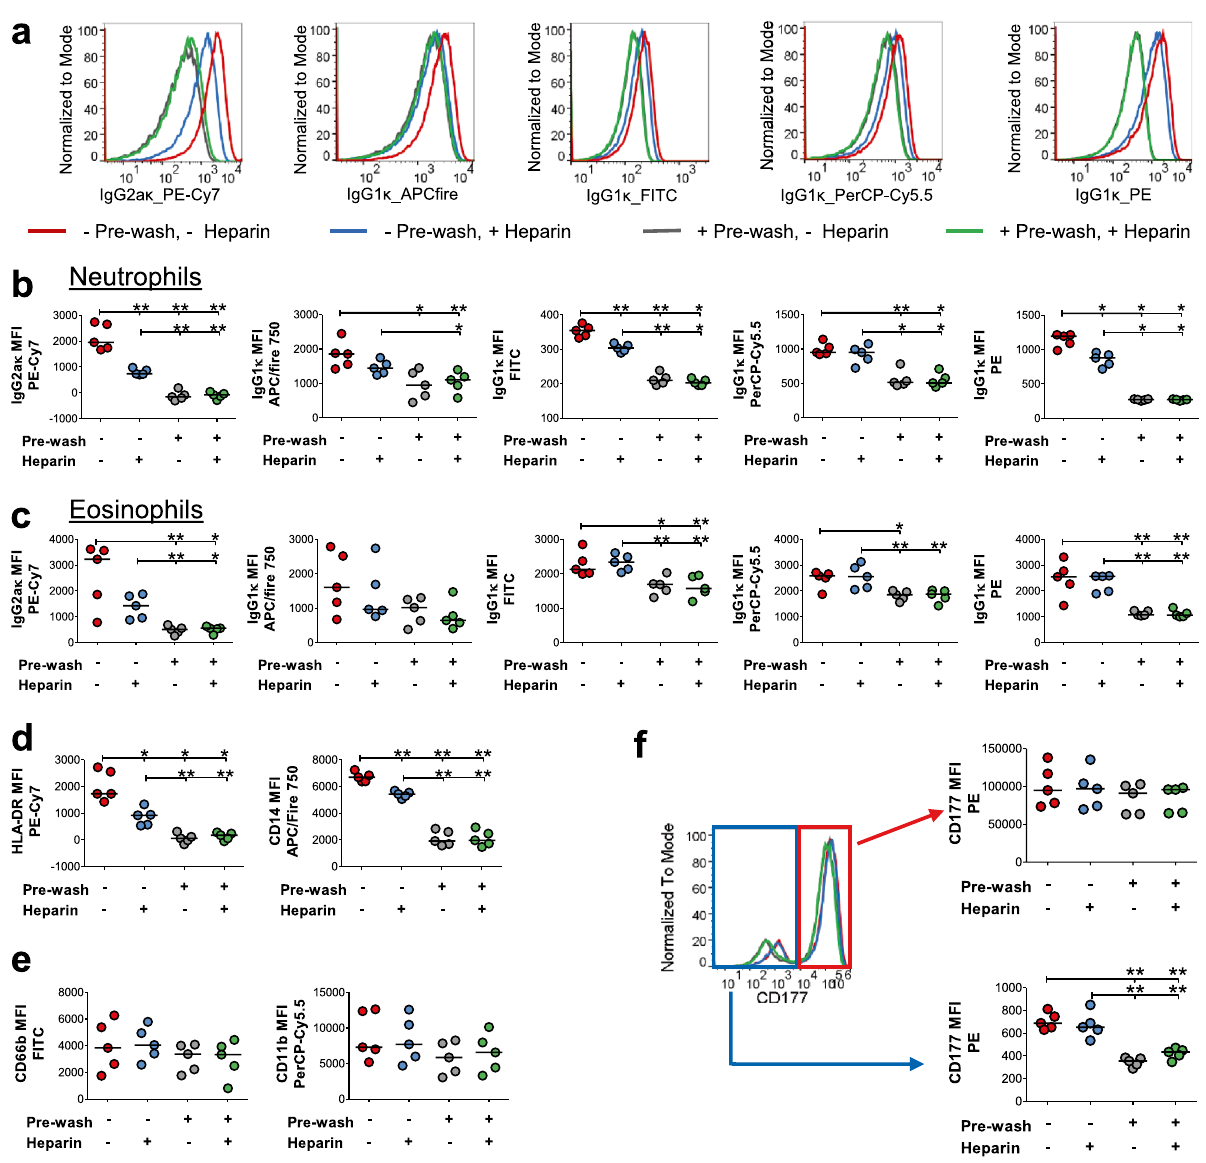
Figure 3. Removal of unbound antibodies prior to RBC lysis and fixation reduces nonspecific antibody binding. WB from healthy donors was collected in ACD tubes and staining was performed at 4 °C in the presence or absence of heparin with or without pre-washing to remove unbound antibodies before fixation and RBC lysis. ( a ) Representative histogram overlays of nonspecific antibody binding to neutrophils in the presence or absence of heparin with or without pre-washing step. ( b , c ) Nonspecific antibody binding to ( b ) neutrophils and ( c ) eosinophils. ( d , e ) Neutrophil surface levels of ( d ) low-level (HLA-DR and CD14) and ( e ) high-level (CD66b and CD11b) proteins. ( f ) Representative histogram overlay and quantification of neutrophil surface levels of CD177 on either CD177 high (top) or CD177 neg (bottom) neutrophils. Bars indicate medians; * p < 0.05, ** p < 0.01; analyzed using Mann–Whitney